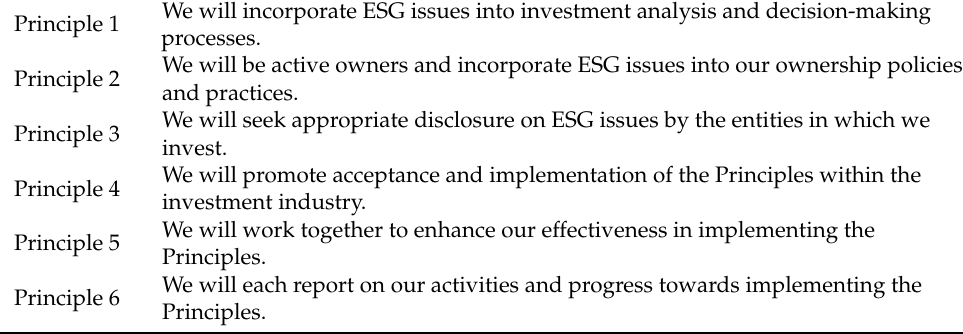
Table 1. The six principles of responsible